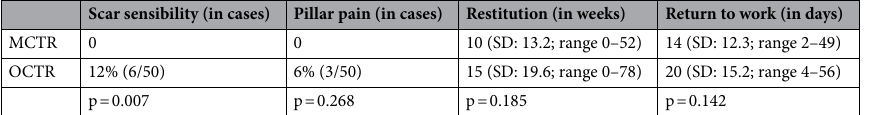
Scar sensibility (in cases) Pillar pain (in cases) Restitution (in weeks)